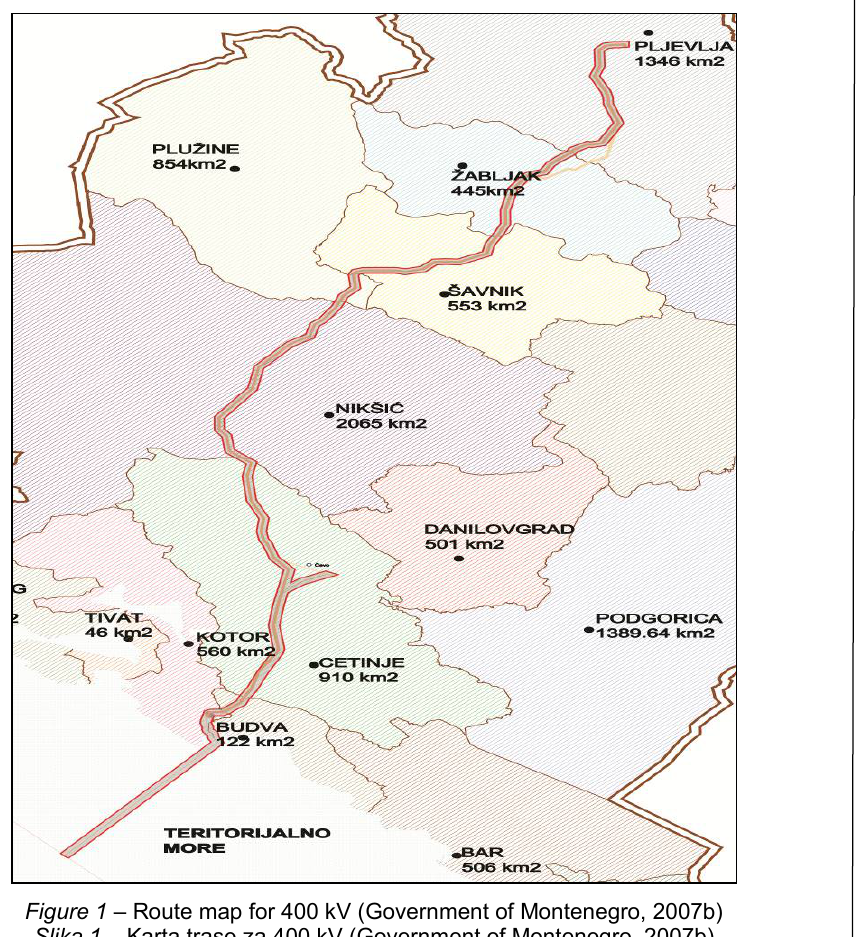
Рис . 1 – Карта трассы кВ ( Правительство Республики Черногория ,